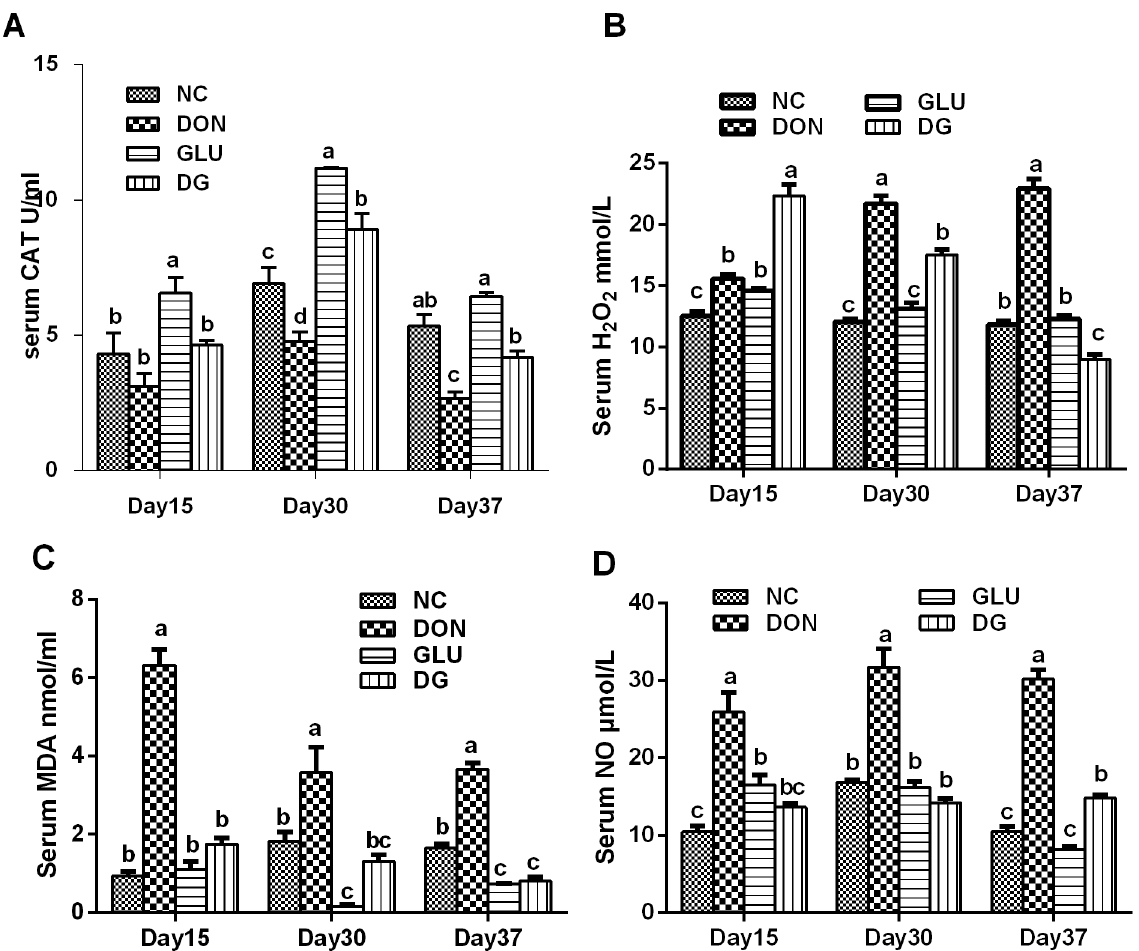
Figure 1. Blood anti-oxidative capacity in each group. A: CAT activity in each group. B: H 2 O 2 concentration in each group. C: MDA concentration in each group. D: NO concentration in each group. Dietary treatments were NC, an uncontaminated basal diet, DON, the basal contaminated with 4 mg/kg deoxynivalenol, GLU, uncontaminated basal diet with 2% (g/g) glutamic acid supplementation, and DG, deoxynivalenol- contaminated (4 mg/kg) basal diet with 2% (g/g) glutamic acid supplementation. Data are presented as means 6 SEM, n=7, with a–c used to indicate a statistically significant difference (P , 0.05, one way ANOVA method). CAT: catalase (U/ml); H 2 O 2 : hydrogen peroxide (mmol/L); MDA: methane dicarboxylic aldehyde (nmol/ml); NO: nitric oxide ( m mol/L).